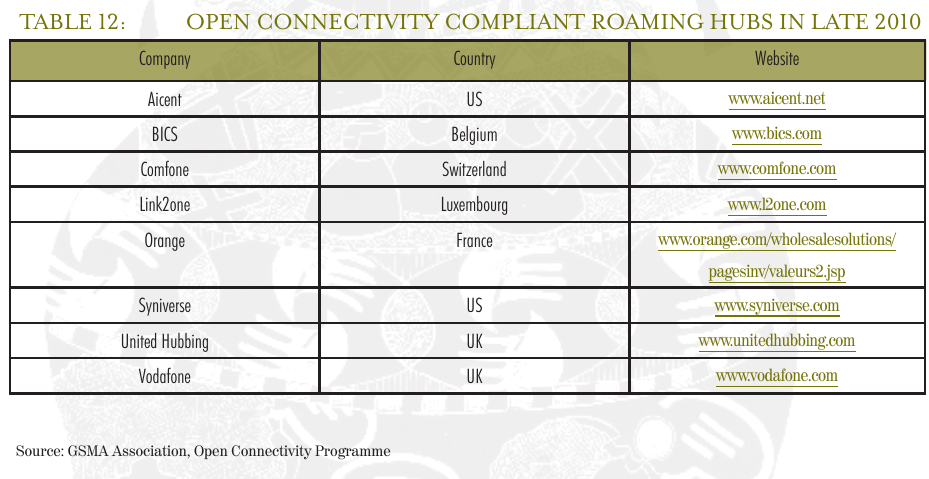
OPEN CONNECTIVITY COMPLIANT ROAMING HUBS IN LATE